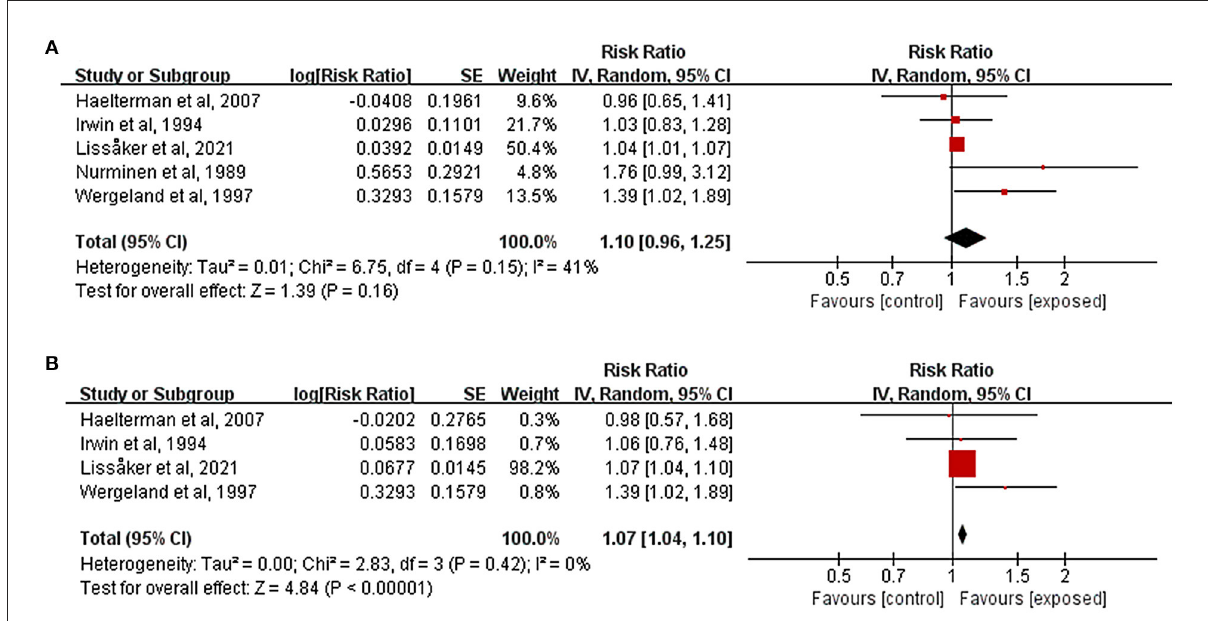
FIGURE3 Forest plots for the relationship between occupational noise exposure and pregnancy complications. Tau 2 , Chi 2 , and df are the statistics in the heterogeneity test, and I 2 is the effect variable attributable to heterogeneity. Z -value is the statistical variable of the overall effect, and inverse variance (IV) is the effect estimation of the study. Effect sizes are given by 95% confidence intervals (95% CI ). The weights are determined by random effects analysis. The size of the boxes around the points reflects the weight assigned to each study. (A) Hypertensive disorders of pregnancy; (B)